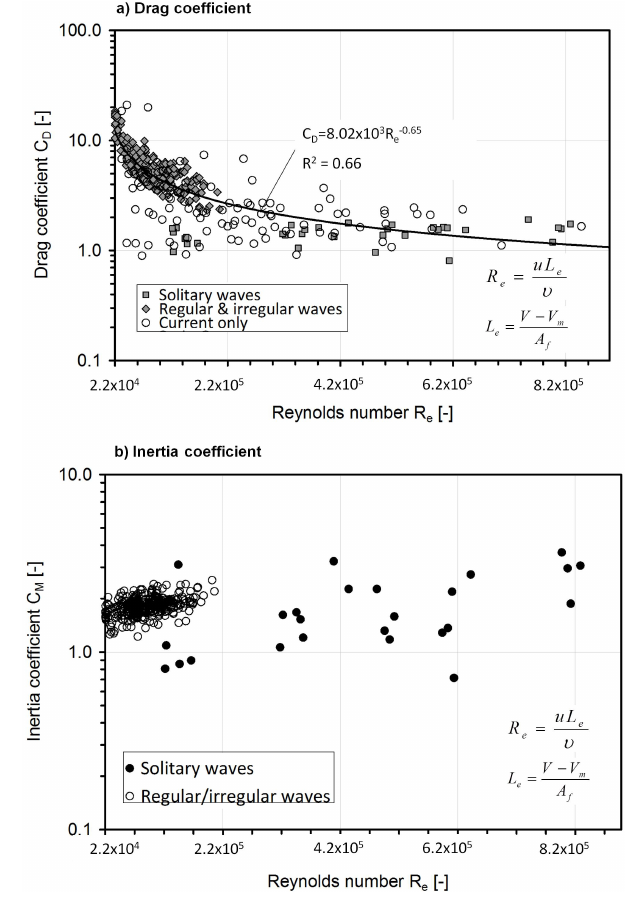
Fig. 15. Flow resistance of mangrove models subject to solitary wave impact in comparison to other investigated flow regimes: (a) drag coefficient, (b) inertia coefficient.